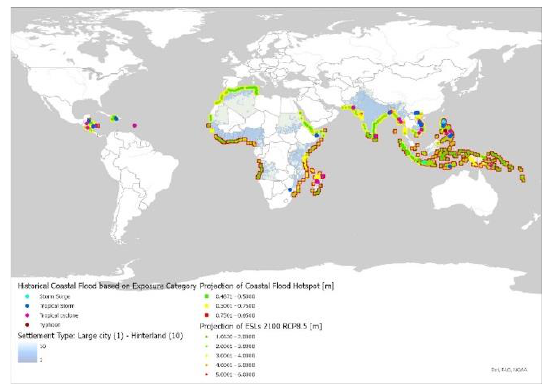
Figure 4. Global distribution of historical (2006-2021), projected Extreme Sea Level (ESL) for RCP8.5 in 2100, and Coastal ' Hotspot' across LLMIC